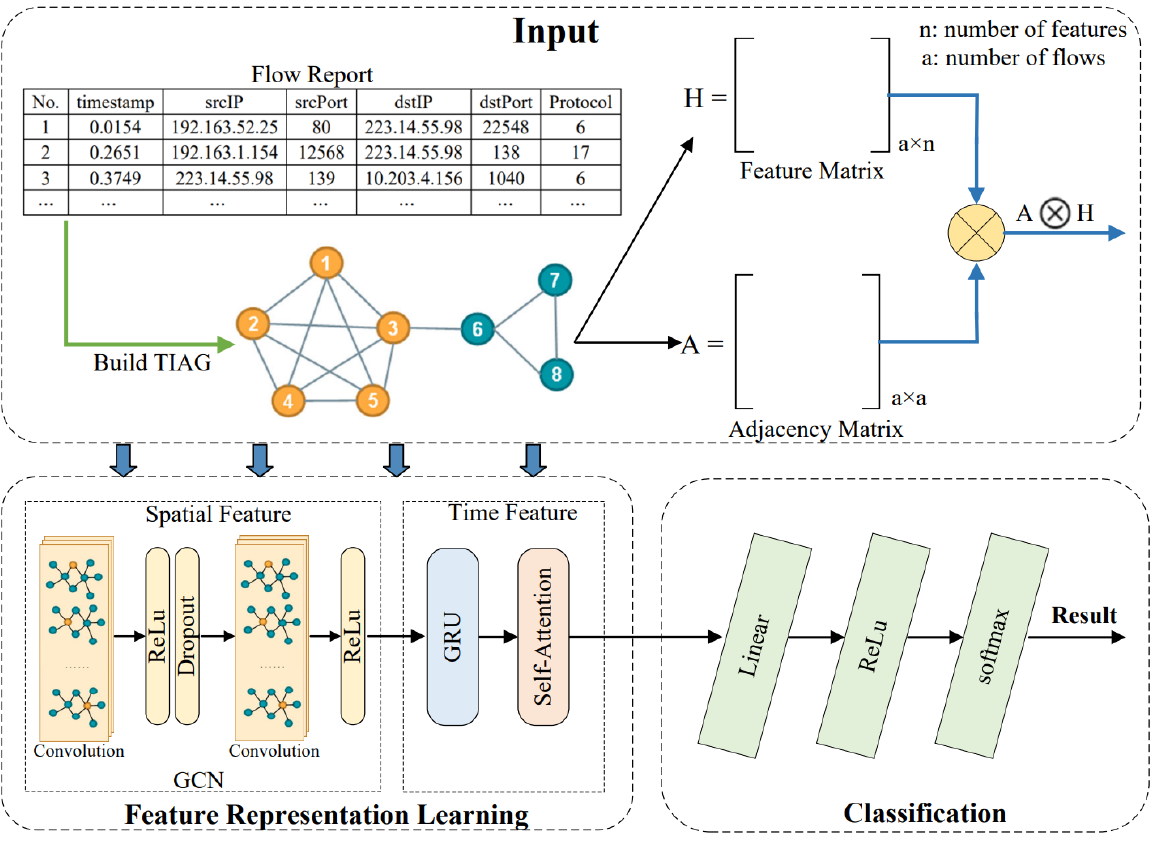
Figure 6. Structure of G-TIAG .